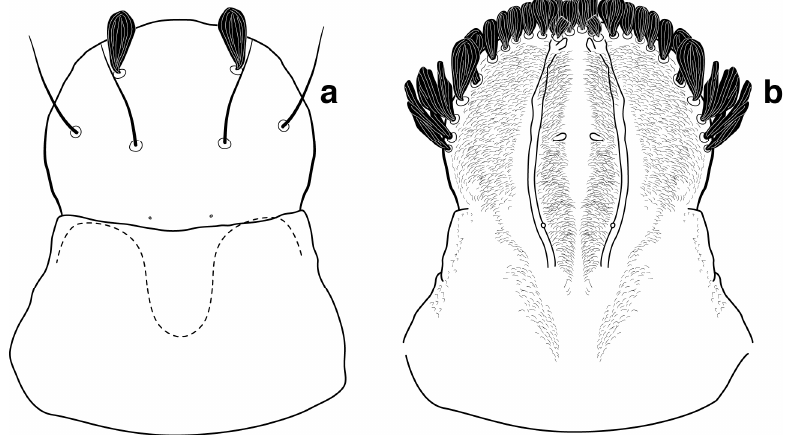
Figure 77. Rhinostomus barbirostris mouthparts: ( a ) clypeus (without setae) and labrum; and ( b ) epipharynx.